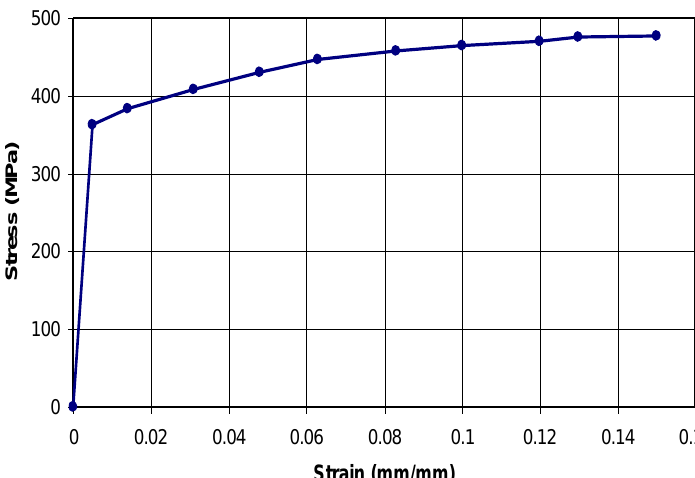
Figure 2: True strain-stress curve of 2024 T351